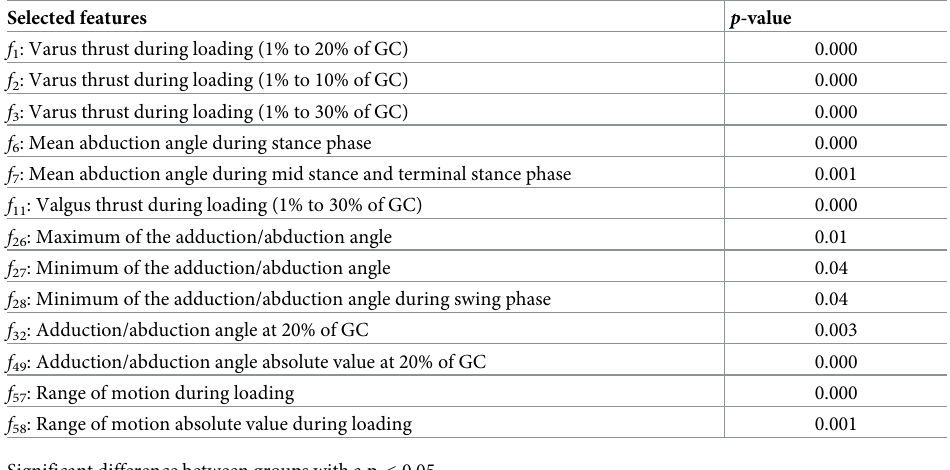
Table 3. Features arising following single feature complexity analysis. Selected features